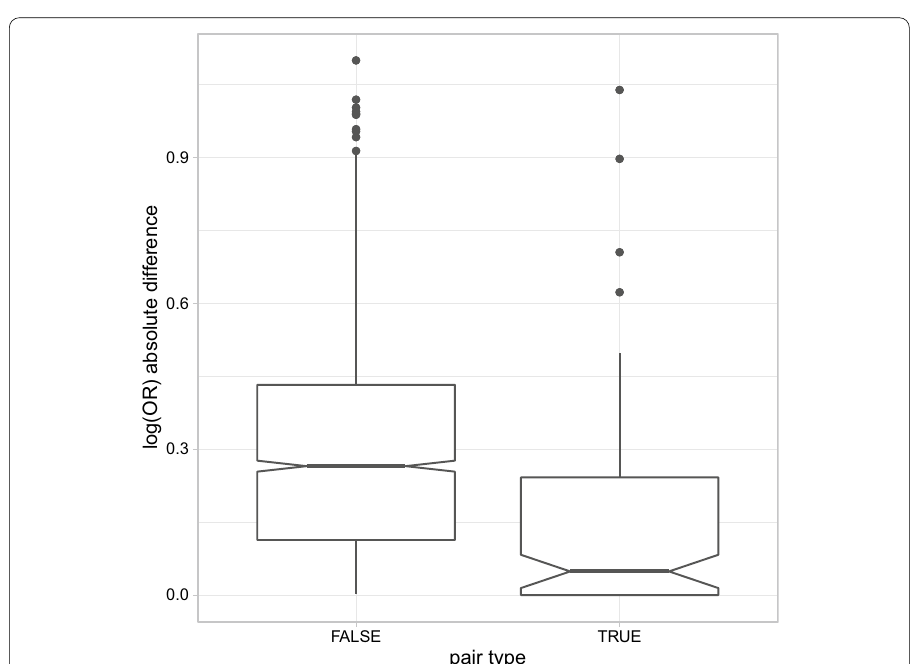
Fig. 3 The distribution of absolute differences between log odds ratios of all pairs by pair